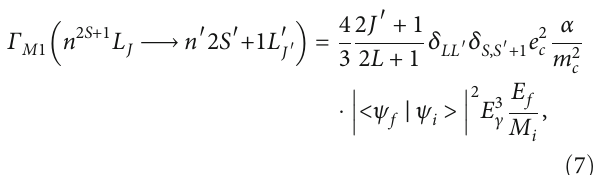
3.3. E1 Radiative Transitions. Electric dipole ( E 1 ) radiative transitions obey the selection rule Δ L = ±1 and Δ S = 0 . The